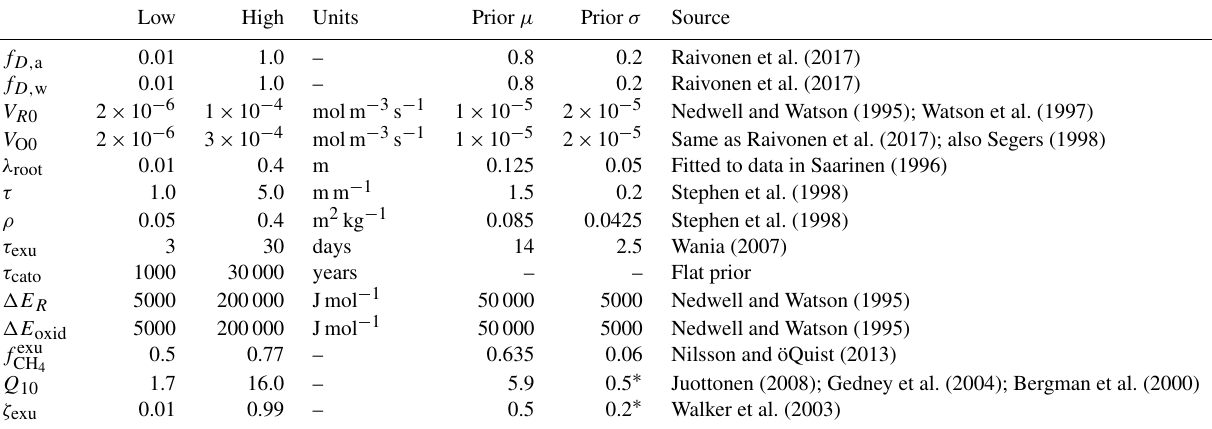
Table 3. Parameter limits and prior distribution parameters. The priors are truncated Gaussian, with mean values µ and standard deviations σ , truncated at the values in the columns “low” and